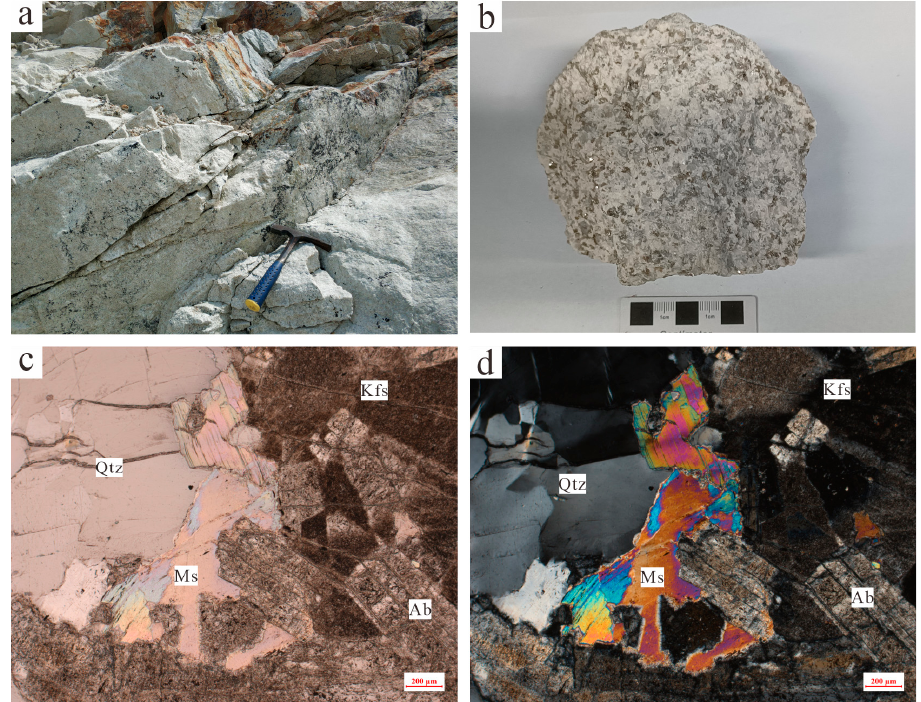
Figure 2. Field pictures and microphotographs of the Dongcao muscovite granite: ( a ). field outcrops; ( b ). hand specimens; ( c ). sample photograph under a single polarizer microscope; and ( d ). sample photograph under an orthogonal optical microscope. (Legend description: Qtz, Kfs, Ab, and Ms denote quartz, alkali feldspar, albite, and muscovite, respectively).